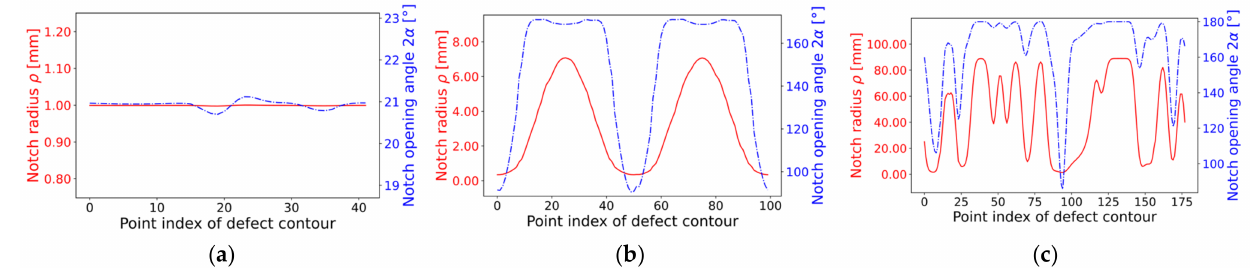
Figure 8. Notch radius and notch opening angle for three defect geometries: ( a ) Circular hole-in- plate (mesh ‘circle_lin_R1mm_v1’); ( b ) Elliptical hole-in-plate (mesh ‘ellipsis_lin_rot0deg_v1’); and ( c ) Elongated defect (mesh ‘defect_elongated_lin_v1’).